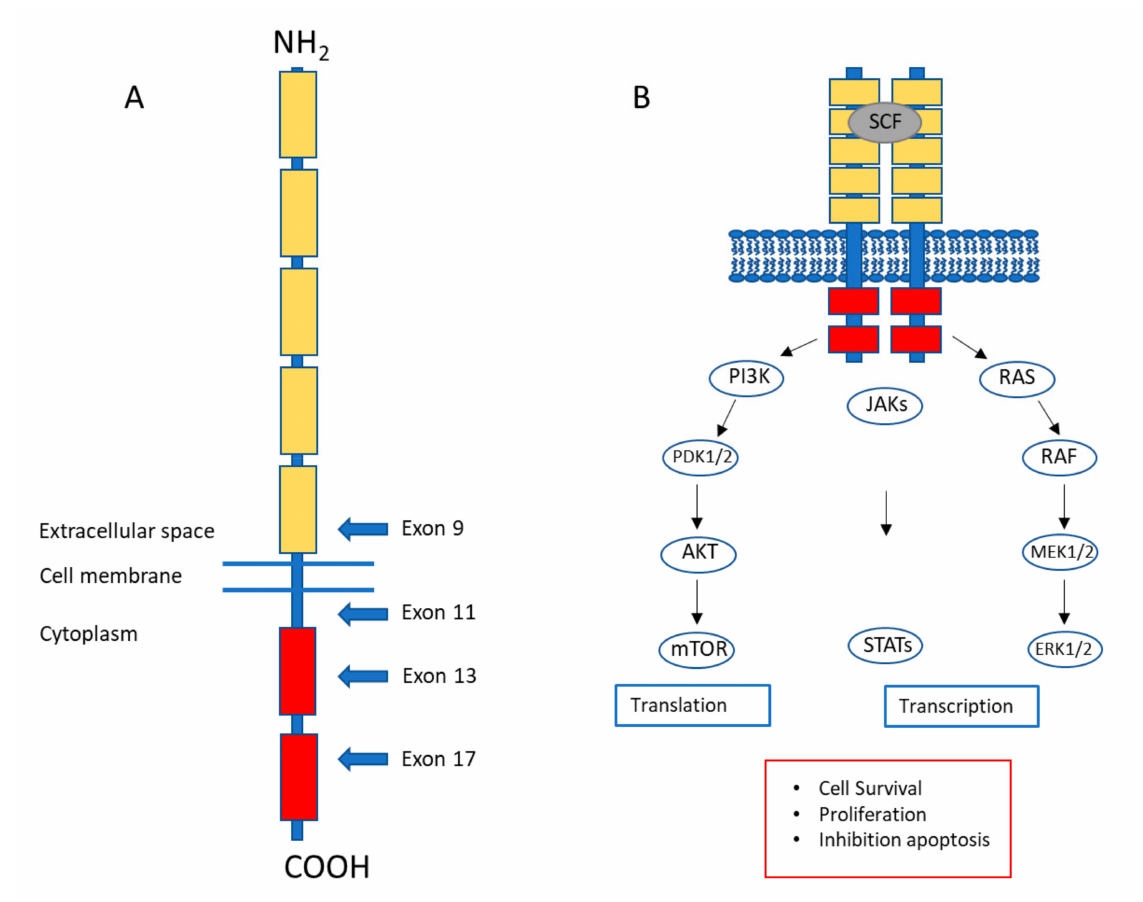
Figure 1. KIT receptor structure and KIT signaling. ( A ) The KIT proto-oncogene codes for a ~110 kDa transmembrane receptor tyrosine kinase KIT (CD117). KIT, together with Platelet Derived Growth Factor Receptor Alpha (PDGFRA), belongs to the type III tyrosine kinase receptor family and consists of 5 extracellular immunoglobulin (Ig)-like domains involved in KIT ligand (Stem Cell Factor, SCF) binding, a transmembrane domain, a juxtamembrane region and an intracellular kinase domain. Mutations in gastrointestinal stromal tumor (GIST) occur in exons that encode functional domains (arrows). ( B ) Constitutive KIT signaling as observed in GIST is transduced through the PI3K / AKT / mTOR, RAS-RAF-MAPK and JAK / STAT pathways thereby inhibiting apoptosis, promoting cell survival and